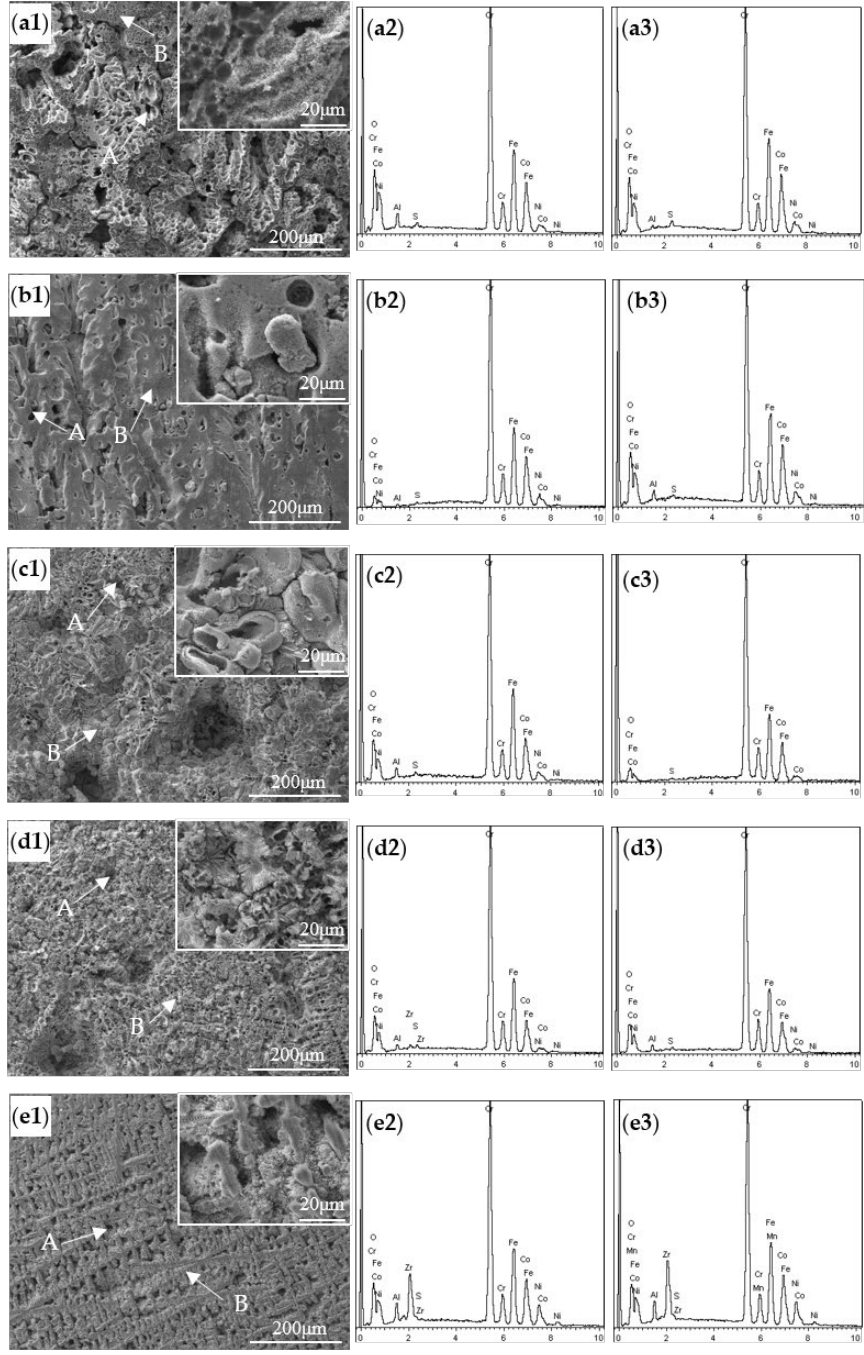
Figure 2. Corroded surface morphologies ( a1 , b1 , c1 , d1 , e1 ) and typical EDS spectra in region A ( a2 , b2 , c2 , d2 , e2 ) and region B ( a3 , b3 , c3 , d3 , e3 ) of as-cast AlCoCrFeNiZr x alloys in a 0.5 M H 2 SO 4 solution for 0–192 h immersion tests at 25 °C: ( a ) x = 0, ( b ) x = 0.1, ( c ) x = 0.2, ( d ) x = 0.3, and ( e ) x = 0.5.